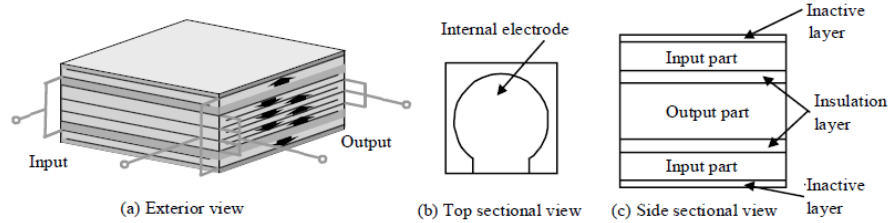
Figure 17. Contour-mode piezoelectric transformer [86].